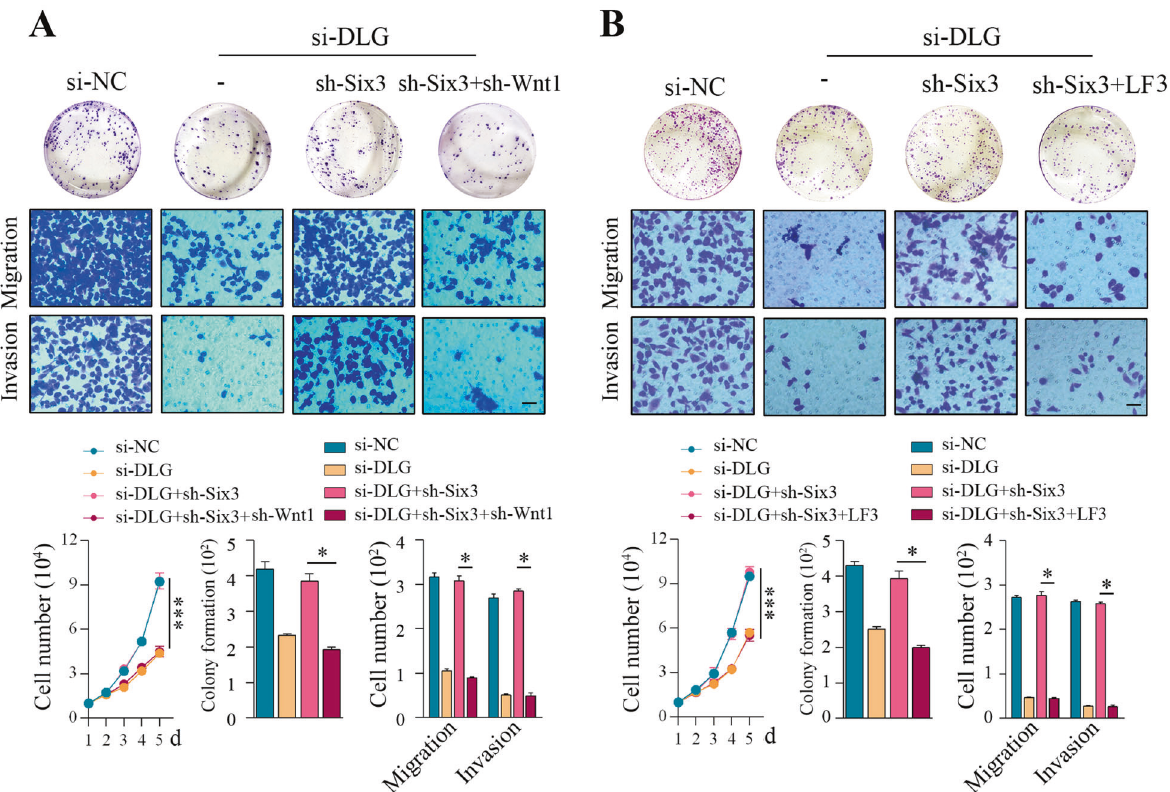
Fig. 6 Inhibition of Wnt1 reversed the malignant phenotypes of GC driven by Six3 depletion. A Colony formation assays, migration assays, invasion assays, and cell proliferation assays in AGS cells upon transfection of si-NC, si-DLGAP1-AS2, si-DLGAP1-AS2 + sh-Six3, or si-DLGAP1- AS2 + sh-Six3 + sh-Wnt1. B Colony formation assays, migration assays, invasion assays, and cell proliferation assays in AGS cells upon transfection/treatment with si-NC, si-DLGAP1-AS2, si-DLGAP1-AS2 + sh-Six3, or si-DLGAP1-AS2 + sh-Six3 + LF3. The data shown are representative of three independent experiments. Scale bar: 20 μ m. * P < 0.05, *** P <